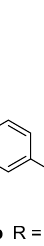
Figure 1. General structure of previously studied diphenylmethyl esters of arecaidine [13].